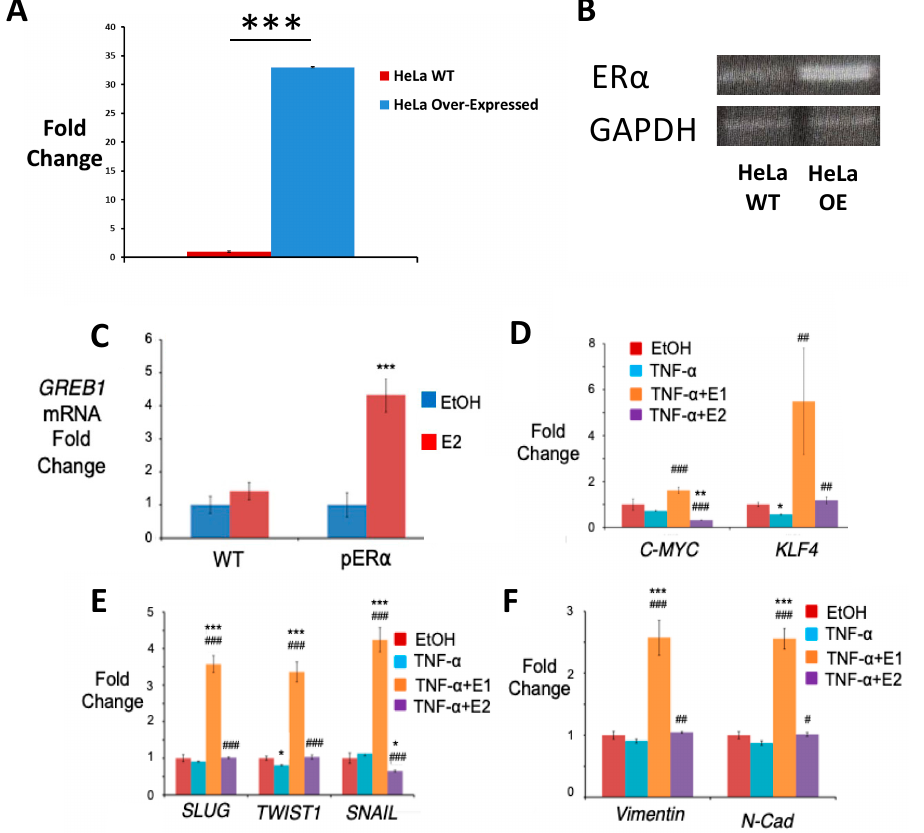
Figure 5. Effect of TNF- α , estrone and estradiol on driving stemness and EMT in HeLa pER α cells. ( A ) Western Blot of ER α expression using GAPDH as housekeeping. ( B ) Gene expression profile of